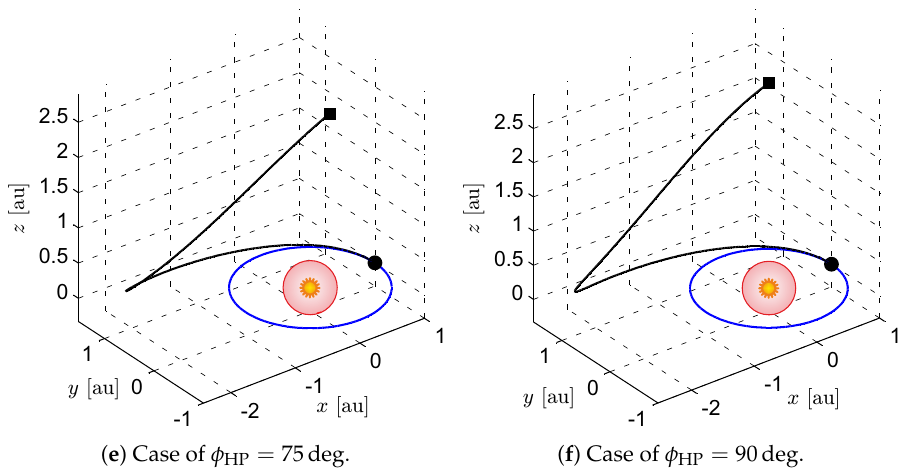
Figure 10. Optimal DT trajectories in a three-dimensional mission scenario as a function of φ HP when r HP = 3au. Black circle → start, and black square → arrival/equilibrium point.